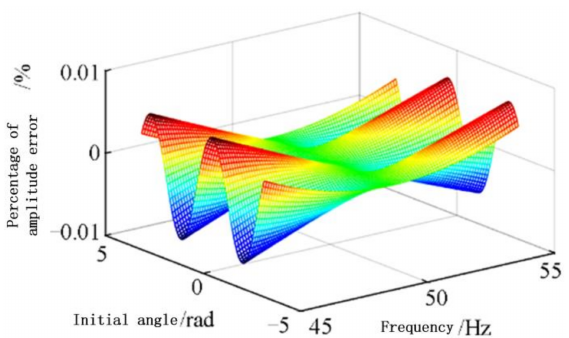
Figure 4. Amplitude error on the change of relationship between frequency and initial angle.